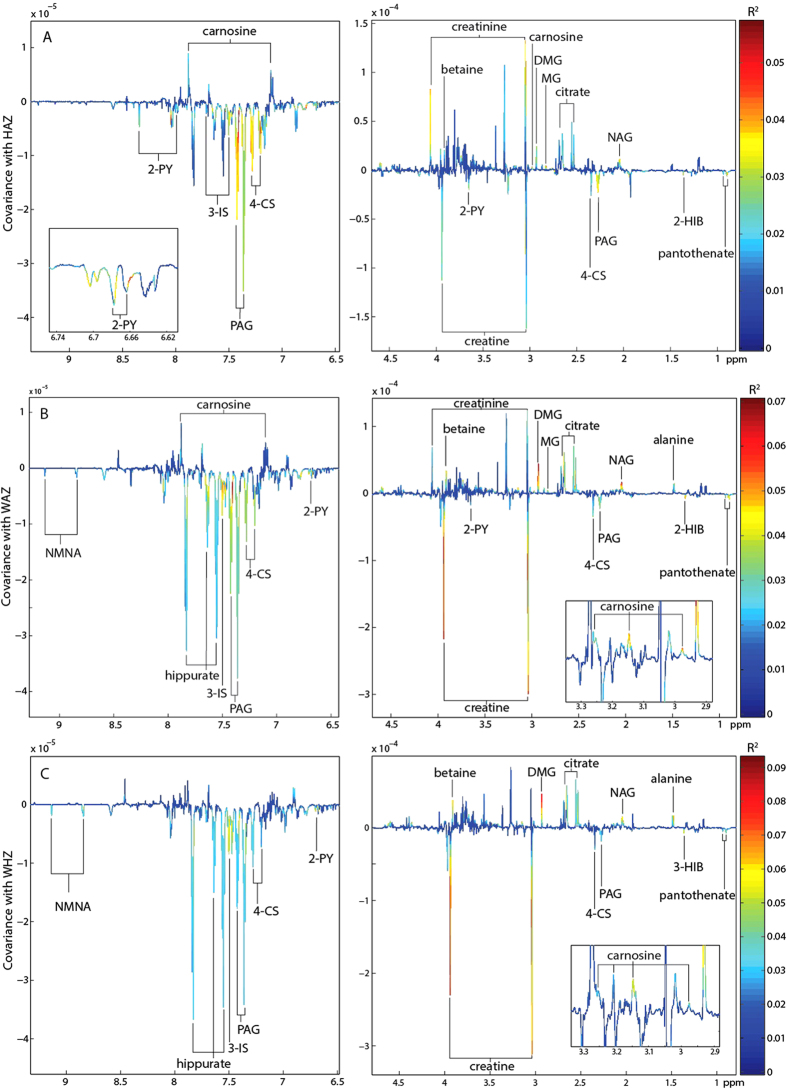
Orthogonal projection to latent structures (OPLS) model identifying metabolic associations with measures of undernutrition.Coefficients plot extracted from the OPLS model constructed from the urinary 1H NMR profiles and corresponding (A) height-for-age z (HAZ)-scores (B) weight-for-age z (WAZ)-scores and (C) weight-for-height z (WHZ)-scores. 2HIB, 2-hydroxyisobutyric acid; 2-PY, N-methyl-2-pyridone-5-carboxamide; 3-IS, 3-indoxyl sulfate; 4-CS, 4-cresyl sulfate; DMA, dimethylamine; DMG, dimethylglycine; MG, methylguanidine; NAG, N acetylglycoprotein; NMNA, N-methylnicotinic acid; PAG, phenylacetylglutamine.